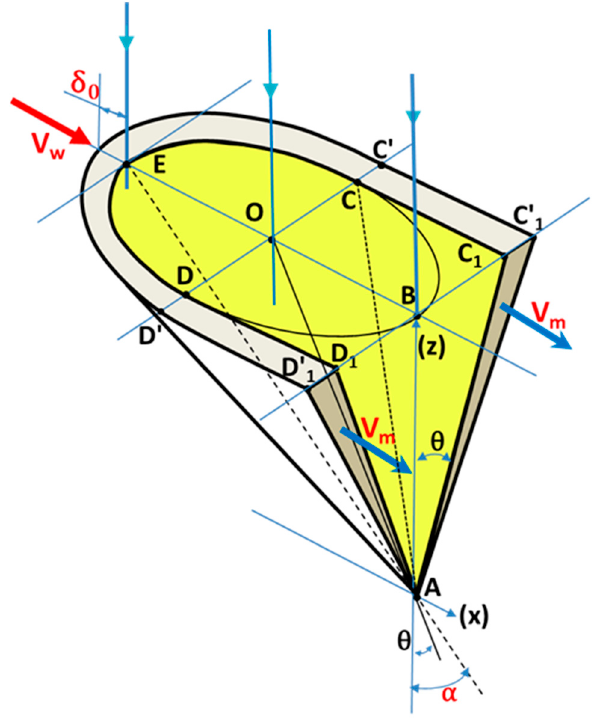
Figure 3. Scheme of the half-cone shape of the KH front used for applying the GPM that describes the dynamic welding regime.